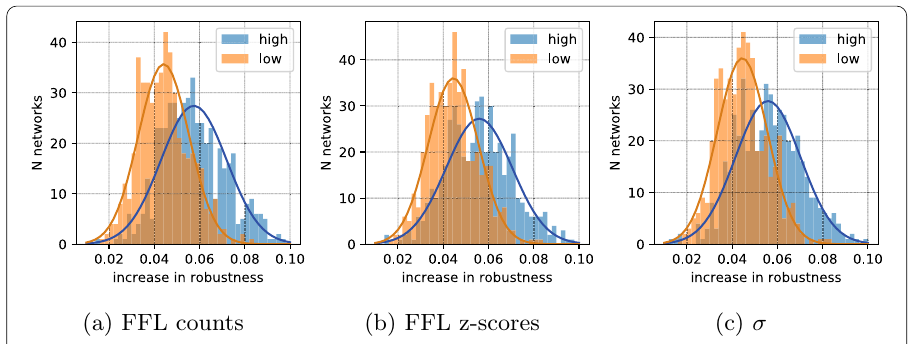
Fig. 9 Histograms of the average increase in robustness for high and low changes in one topological metric. We take 500 random networks that have full demand satisfaction and some robustness. For each combination of a network and an edge that is not in the network, we compute r , motif signature, and three‑node subgraph counts. Then, for each network, we separate combinations into two groups: the ones that yield the highest increase in a simple metric (counts of feedforward loop ( a ), z‑score of feedforward loop ( b ), and σ ( c ))—denoted as high, and the remaining combinations—denoted as low. After this we compare the average increase in r in these two